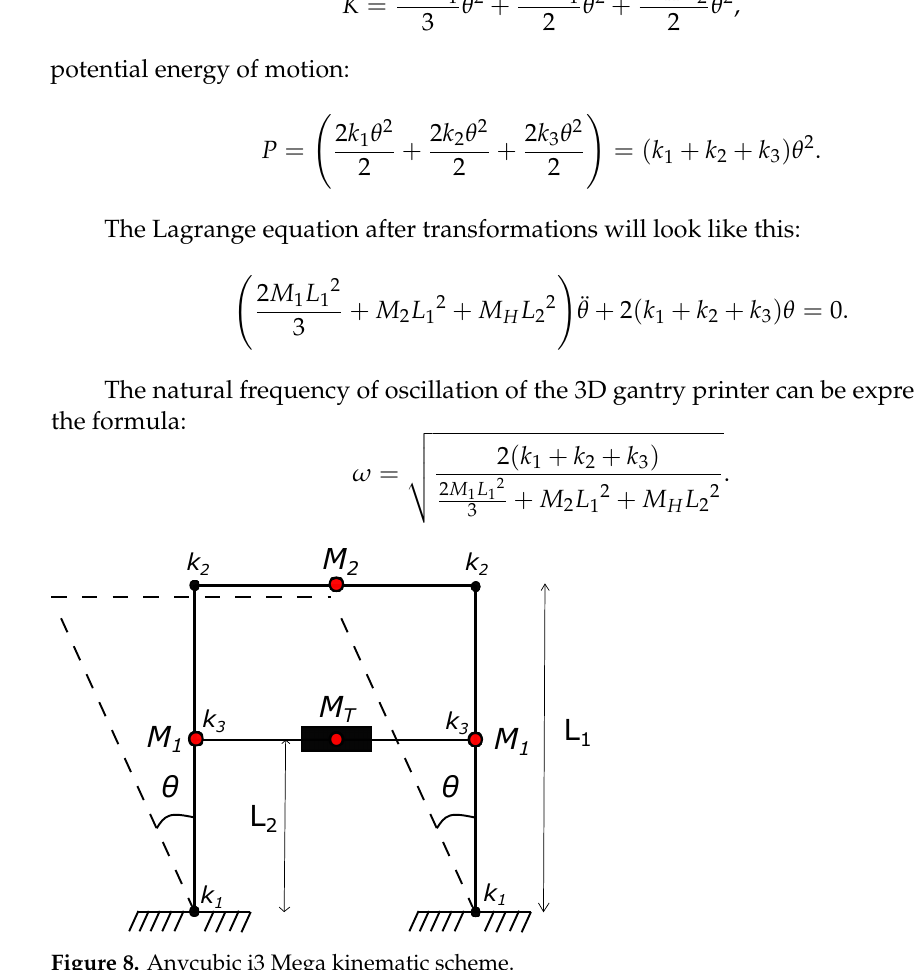
Figure 8. Anycubic i3 Mega kinematic